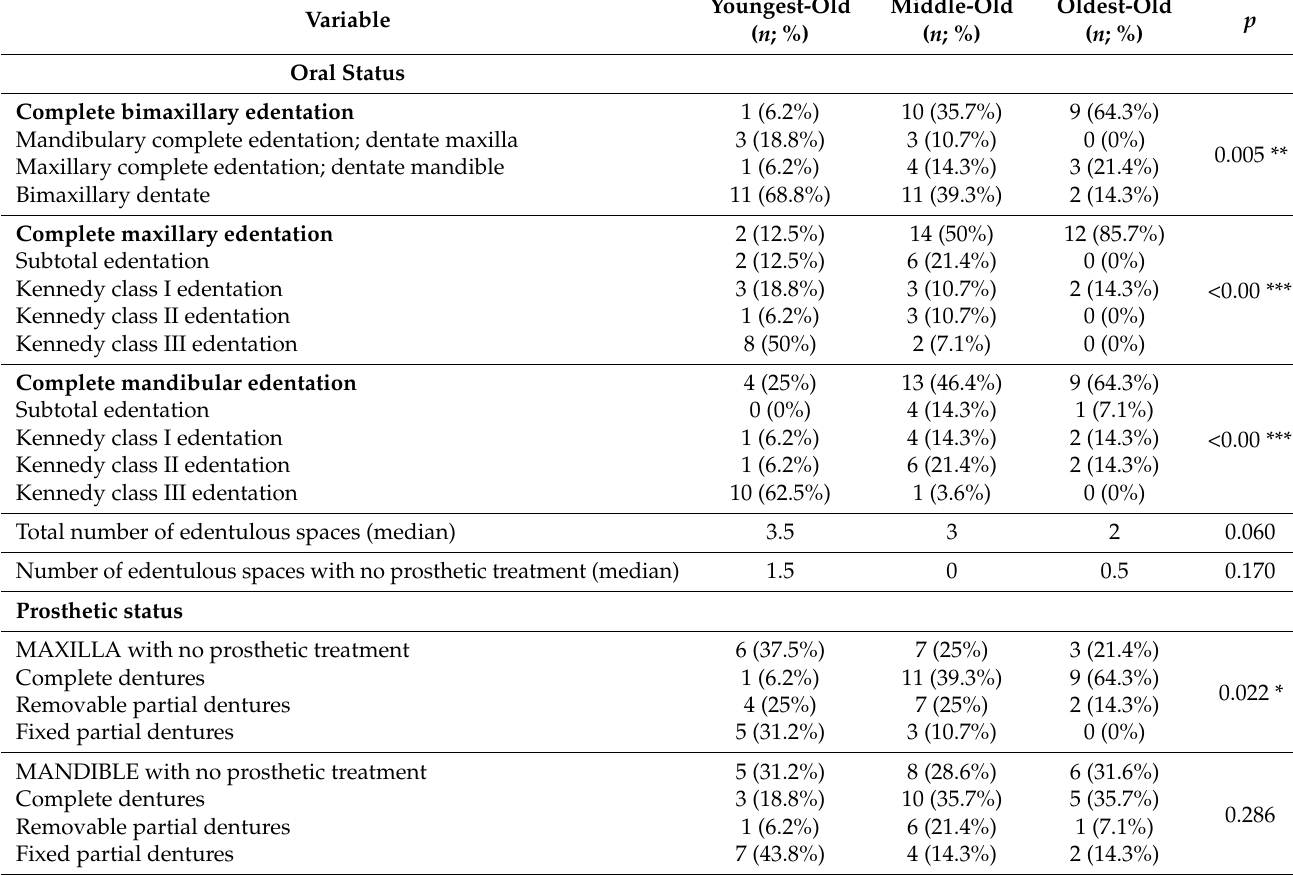
Table 2. Oral and prosthetic status in elderly institutionalized according to different age groups. Variable